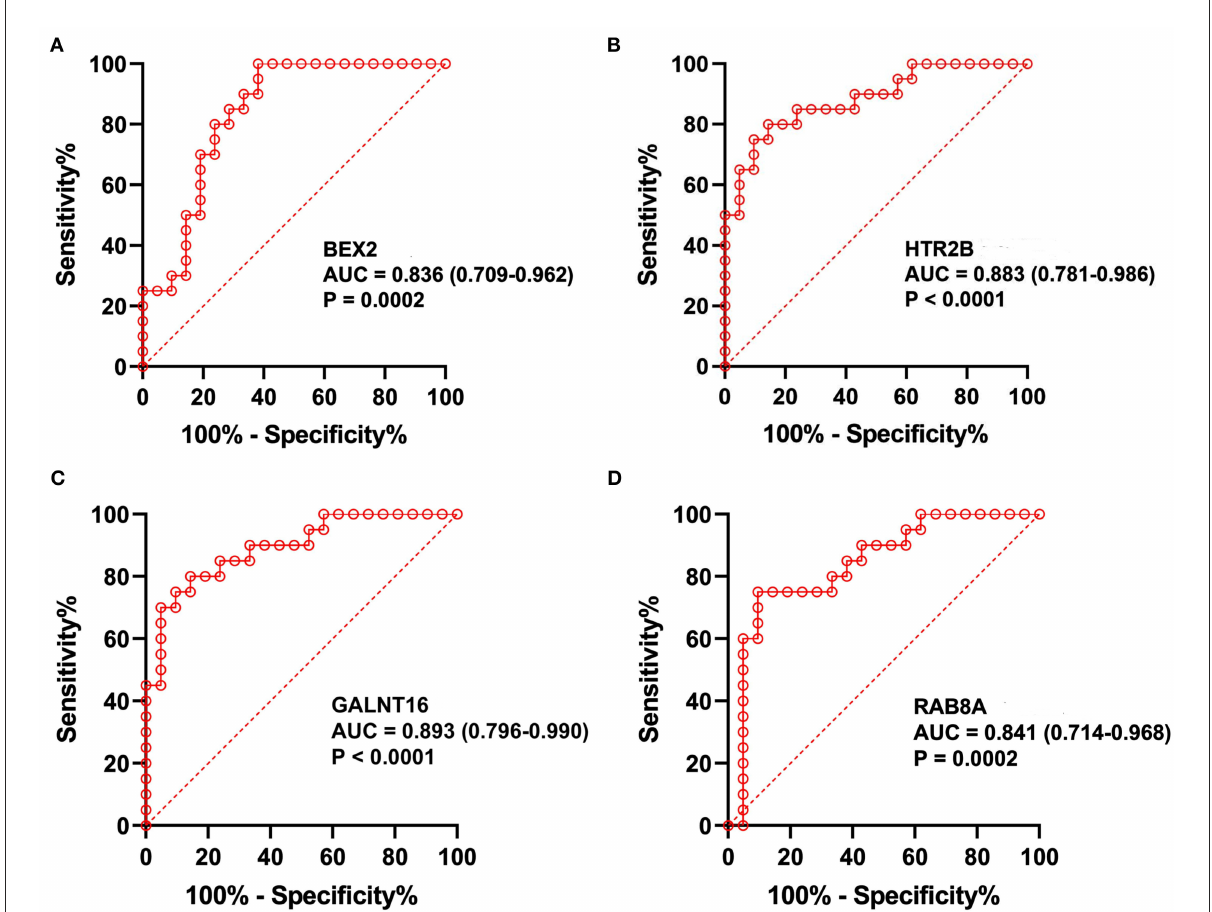
FIGURE7 The analysis of ROC curves in the training set. Representative plots showing the results of ROC curve analysis of BEX2 (A) , HTR2B (B) , GALNT16 (C) and RAB8A (D) in the training set.